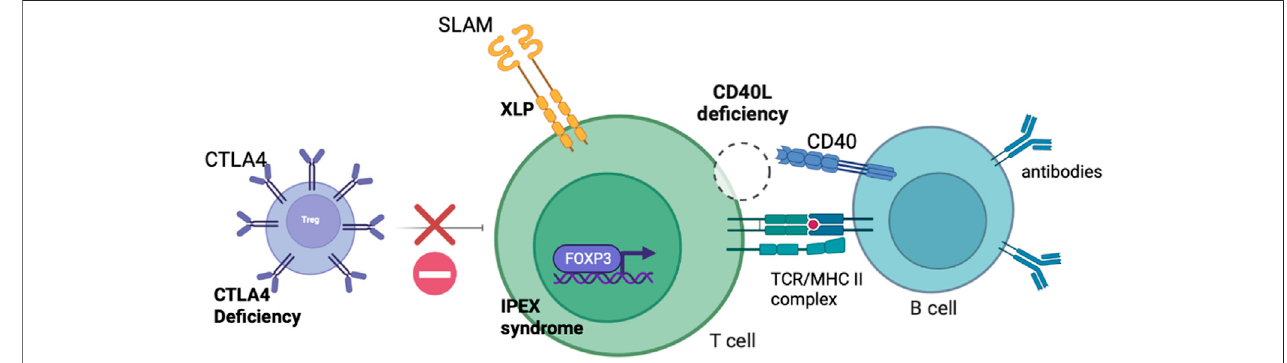
FIGURE2| Schematicdiagramdemonstratingthedefectspresent inIEIswithpredominantlymphocyte defectspotentiallyamenabletocorrectionwithTcellgene editing.